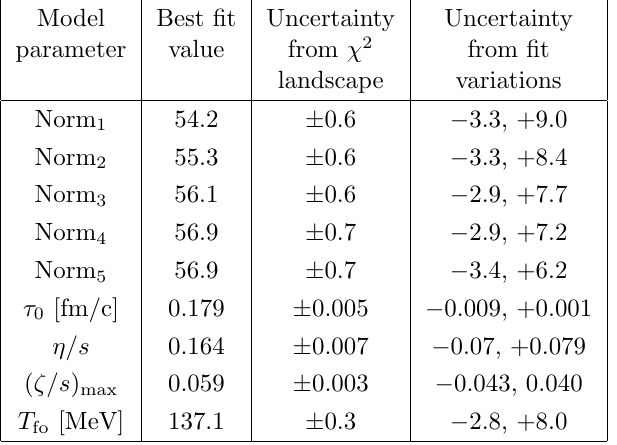
Table 3 . Best (cid:12)t parameters and their uncertainties determined from the (cid:31) 2 landscape through eq. (3.3), and from the variation of the (cid:12)tting procedure as reported in (cid:12)gure 2. For the global (cid:12)t we (cid:12)nd (cid:31) 2 =N dof = 1 :